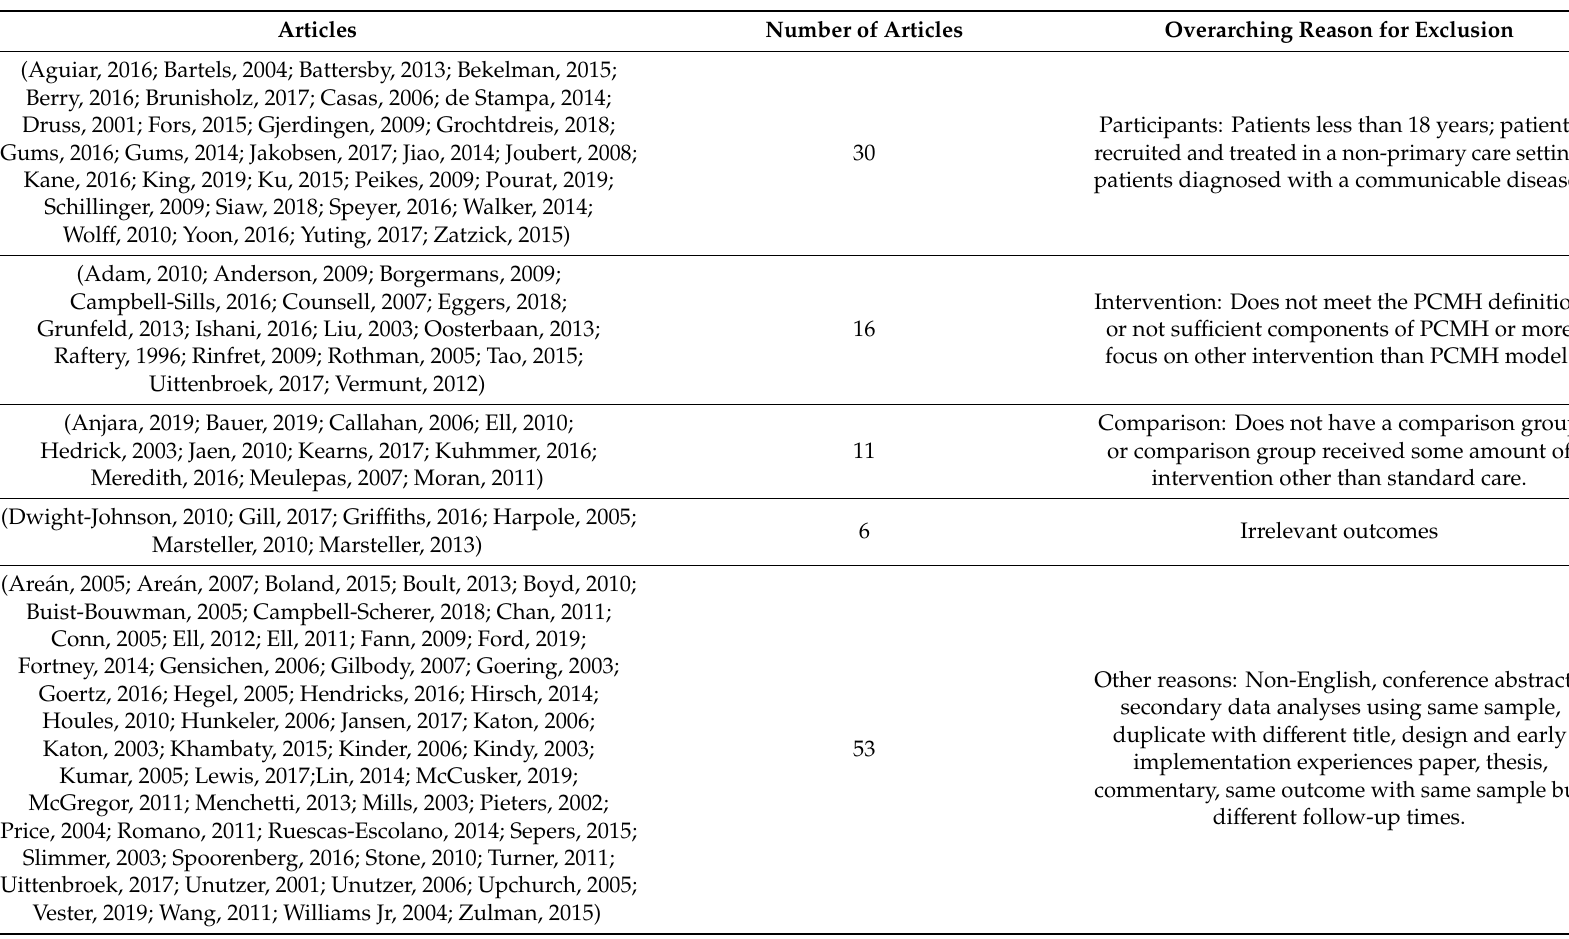
Table A2. List of excluded articles from full-text screening stage with an overarching reason.